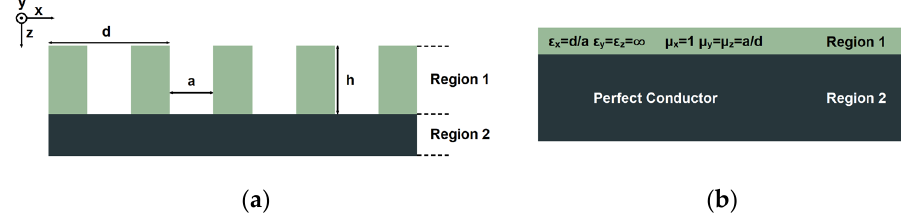
Figure 1. The SSPP structure: ( a ) physical structure and ( b ) equivalent artificial electromagnetic medium structure.